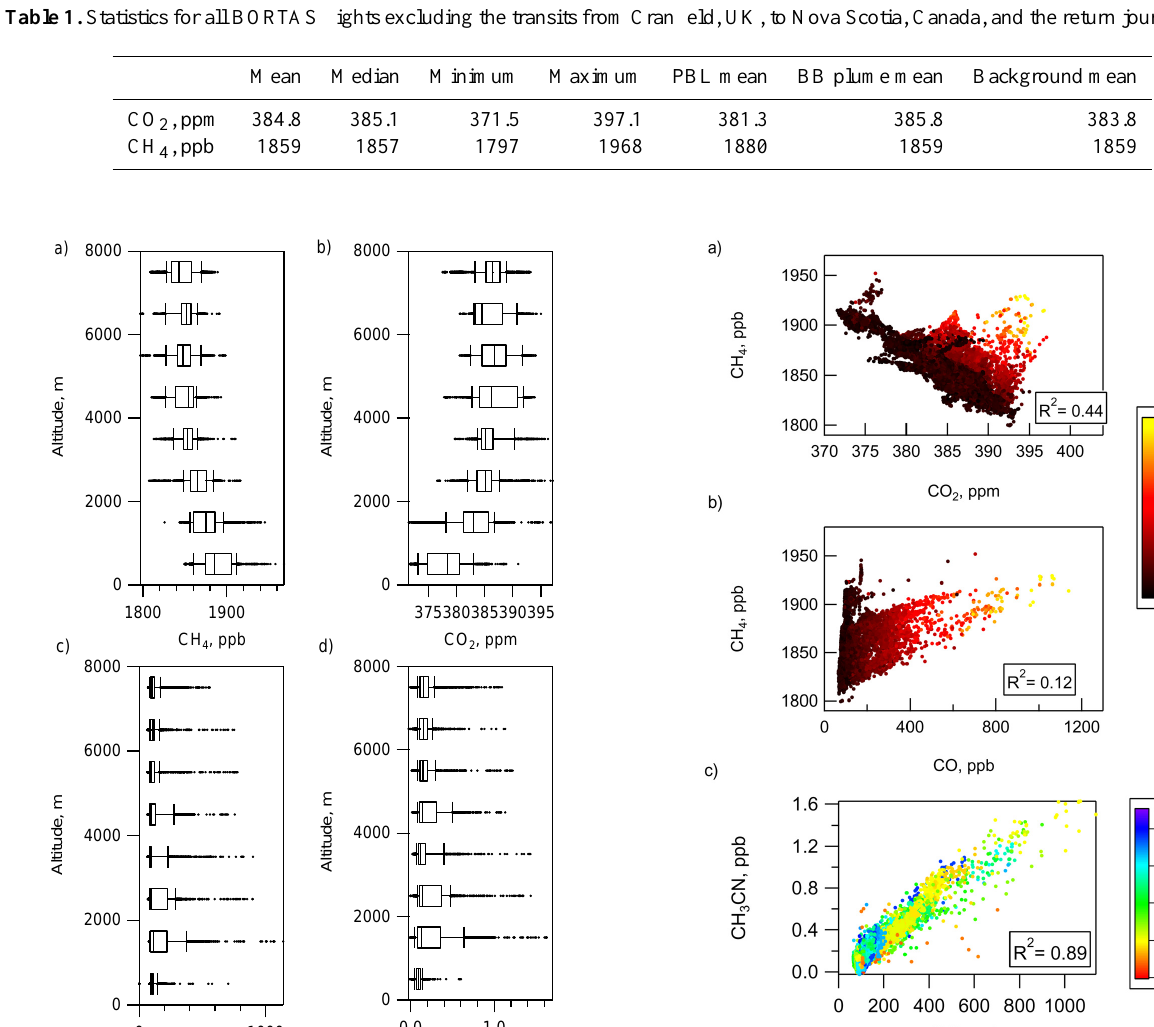
Table 1. Statistics for all BORTAS flights excluding the transits from Cranfield, UK, to Nova Scotia, Canada, and the return journey.